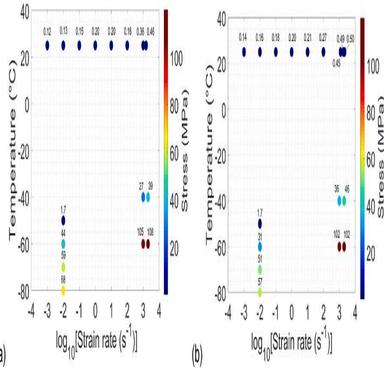
Strain rate and temperature dependence on the peak stress for the 5% filled composites: (a) F-NR2 and (b) F-NR3.